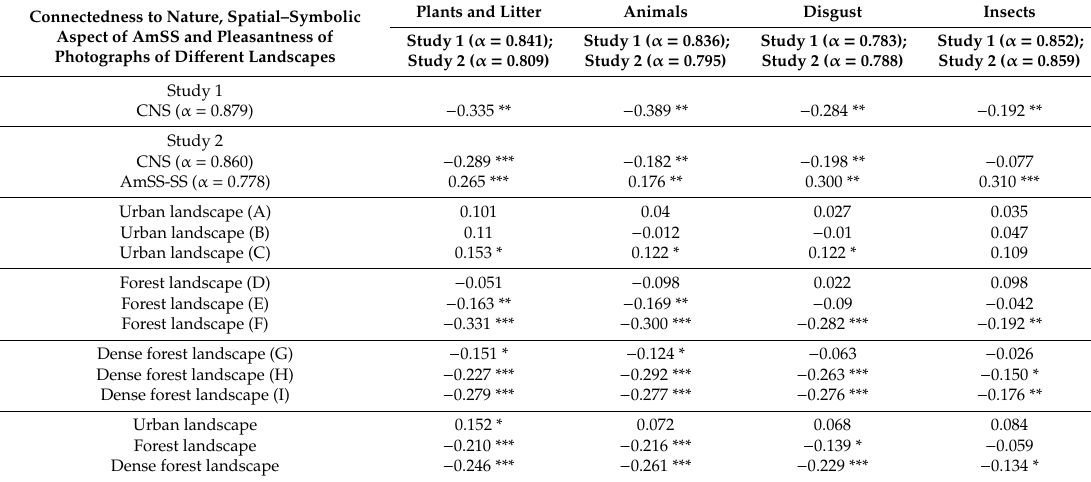
Table 4. Correlations and internal consistency of AEFES, CNS, AmSS-SS and preferred